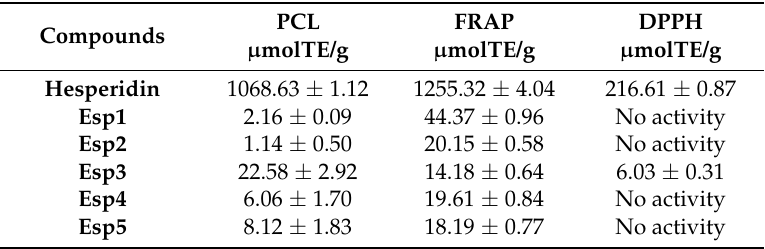
Table 4. Antioxidant assays. Each value was the result of three different experiments (Mean ± SE). Compounds